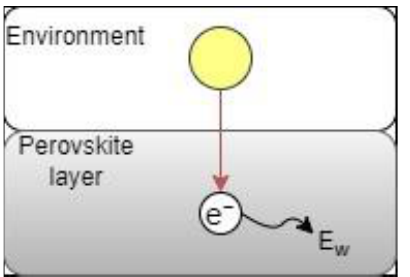
Figure 2. Pathway of photons into electrons in the control case.